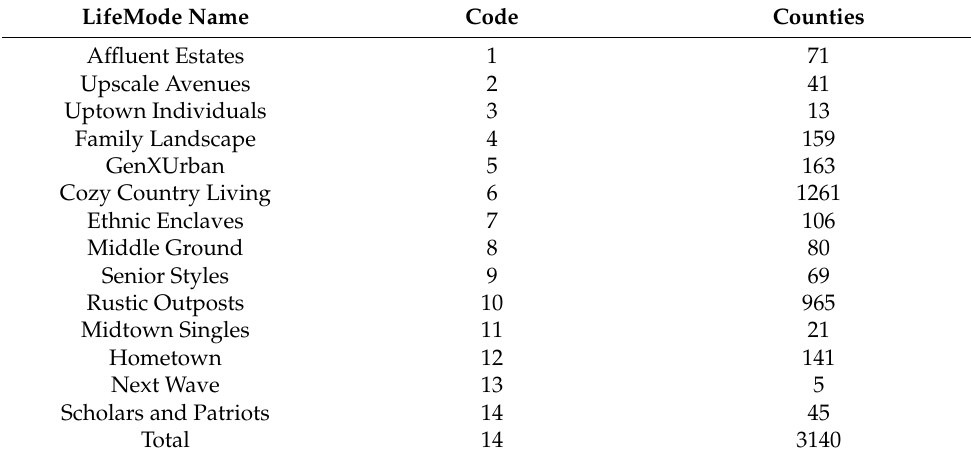
Table 1. Dominant LifeMode within each U.S.